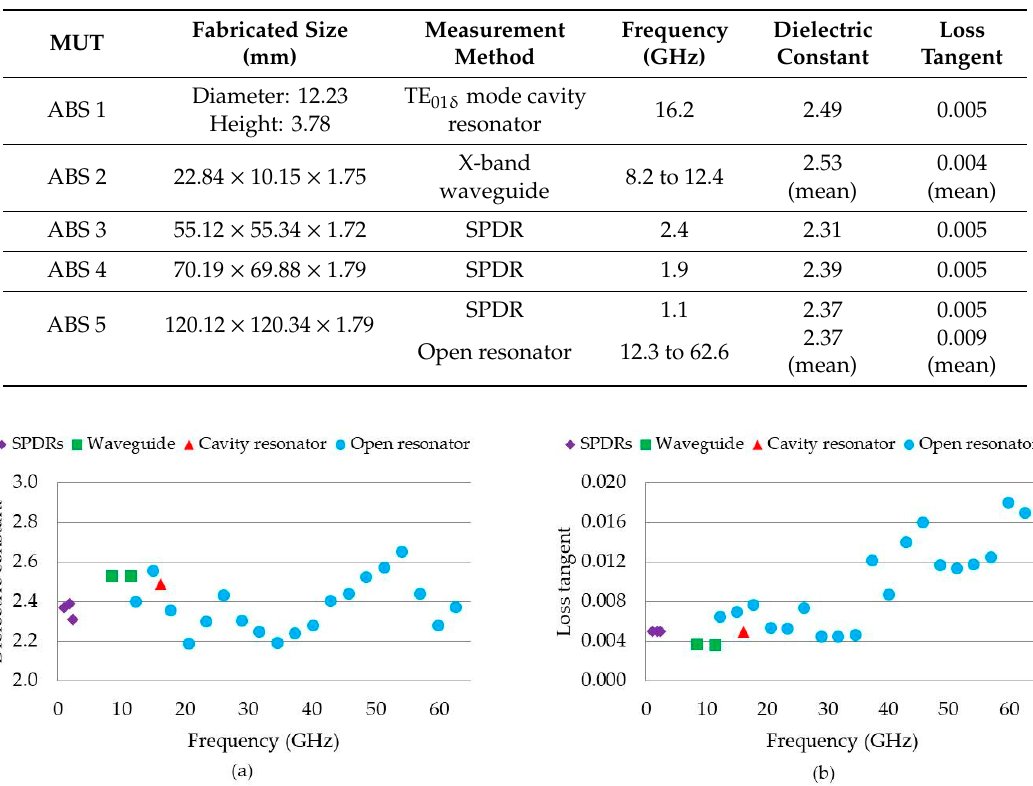
Figure 10. Measured ( a ) dielectric constant and ( b ) loss tangent of ABS MUTs.